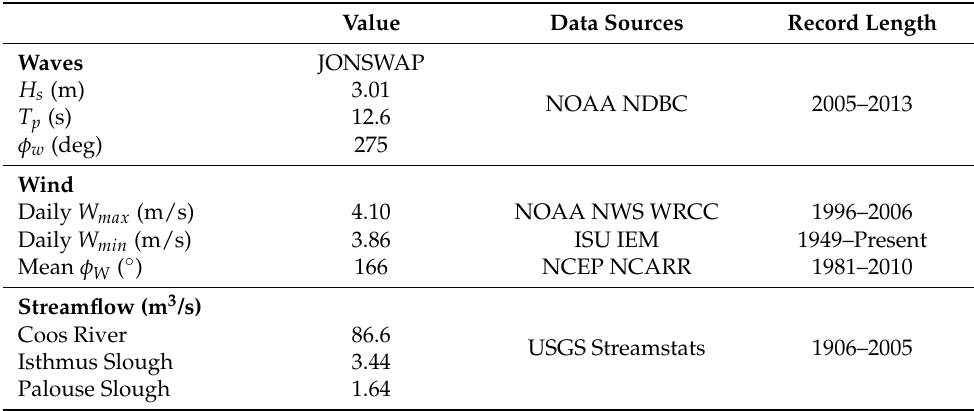
Table 1. Hydrodynamic forcing conditions for Coos Bay Estuary